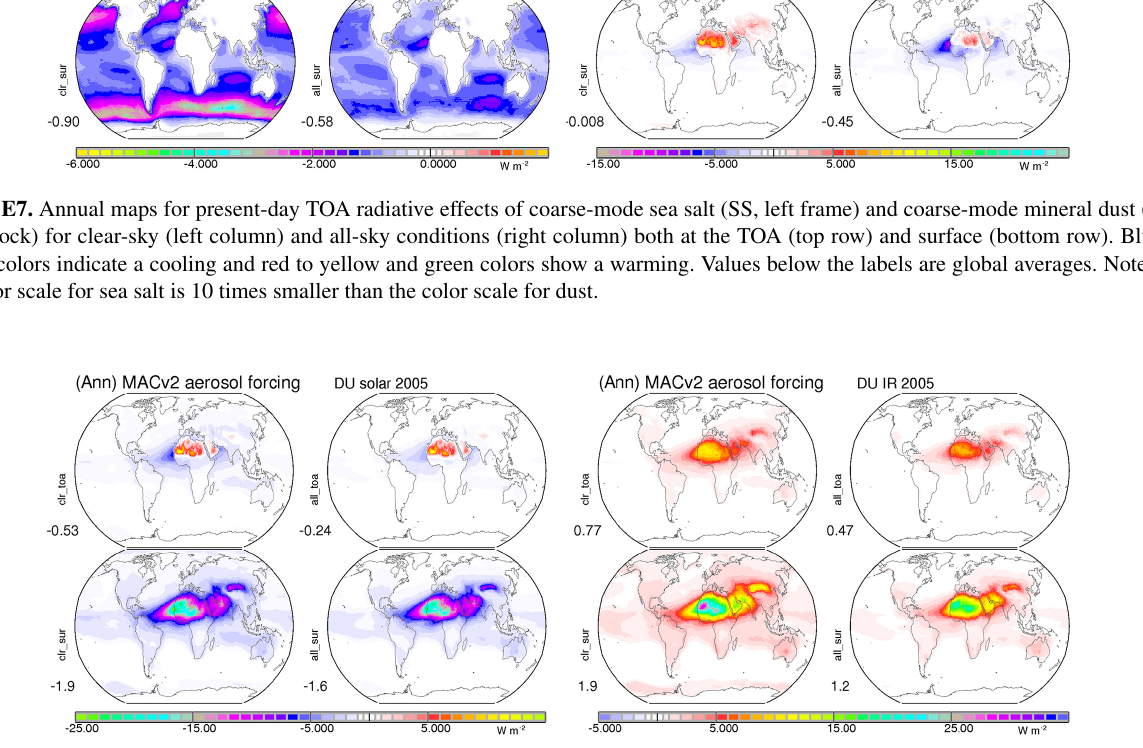
Figure E8. Annual average maps for present-day radiative effects of coarse-mode mineral dust (DU) in the solar spectral (left frame) and the infrared spectral region (right block). Aerosol impacts are shown for clear-sky (left column) and all-sky conditions (right column) for both TOA (top row) and surface (bottom row). Blue colors indicate a cooling and red colors a warming. Values below the labels are global